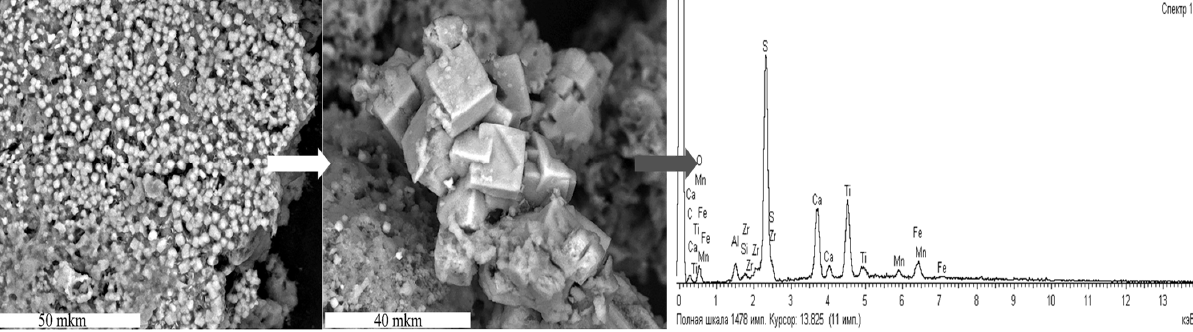
Table 8. Recovery of Zr and REE and losses with silicate gel under various leaching conditions and their concentrations in the pregnant solutions after the gel-like phase